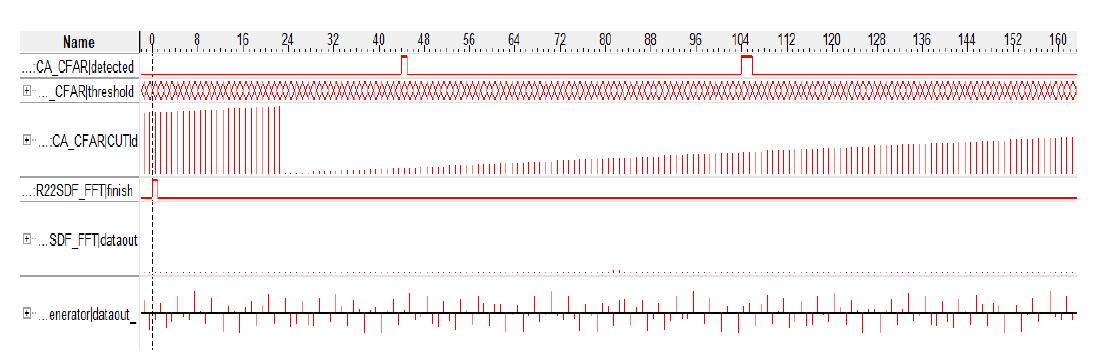
Figure 12. Threshold detection signal-tap results.